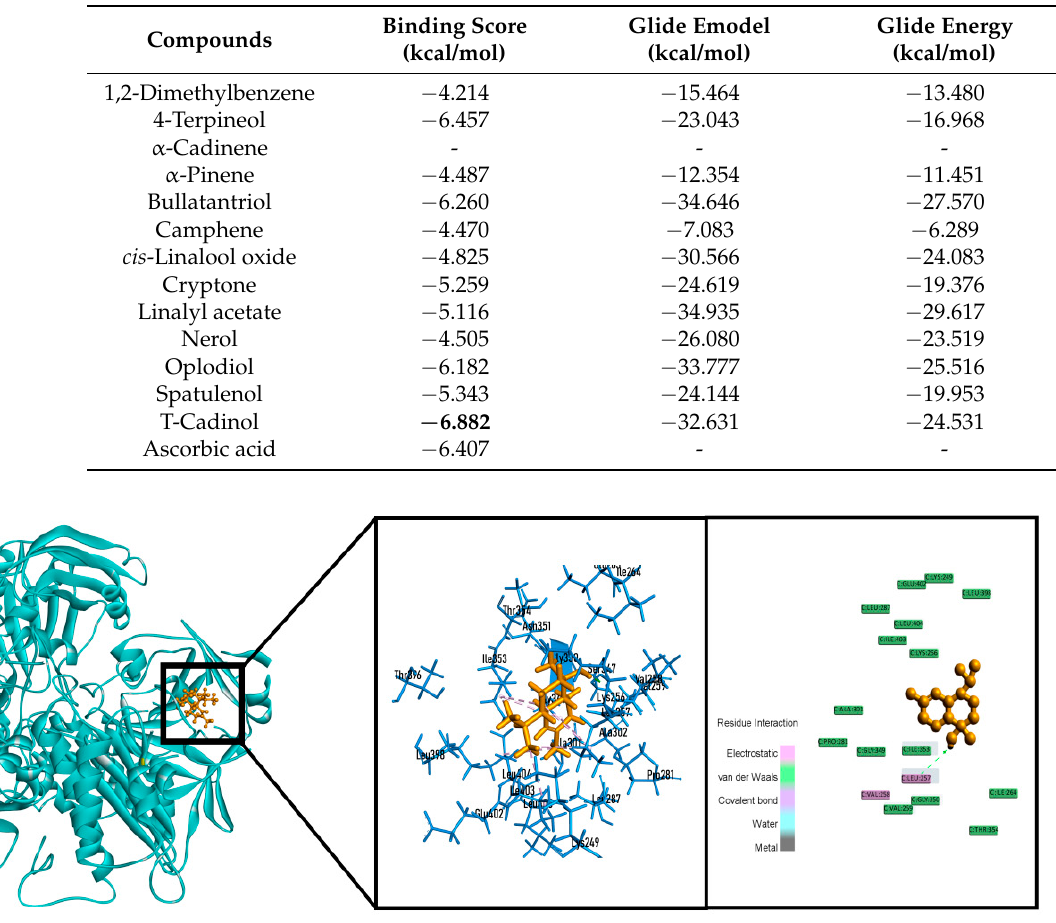
Table 2. Docking score of the phytochemical compounds of essential oil in leaves of H. aromatica against xanthine oxidoreductase (PDB: 2CKJ) for antioxidant activity (Bold indicates lower docking score) .